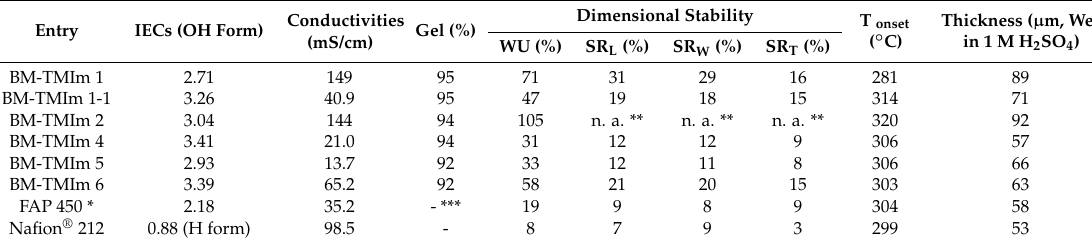
Table 2. The properties of anion-exchange blend